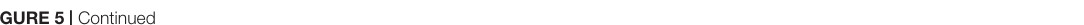
FIGURE 5 | Continued homolog genes for each enzyme, with each column representing different genotypes and different colors indicating different gene expression levels. The number below each metabolite is the log 2 (fold change) value of it. Red text highlights the compounds belonging to isoflavone. The detailed information of genes and metabolites involved in lignin and flavonoid biosynthesis are available in Supplementary Tables 13 – 16 , respectively. Double arrows in sequence represent omitted metabolites and genes. nd, not detected. CAD, Cinnamyl Alcohol Dehydrogenase; CCR, Cinnamoyl-Coenzyme A Reductase; C3H, Cinnamate 3-Hydroxylase; C4H, Cinnamate 4-Hydroxylase; CHS, Chalcone Synthase; CHI, Chalcone Isomerase; 4CL, 4-Coumarate:Coenzyme A Ligase; CCoAOMT, Caffeoyl-Coenzyme A